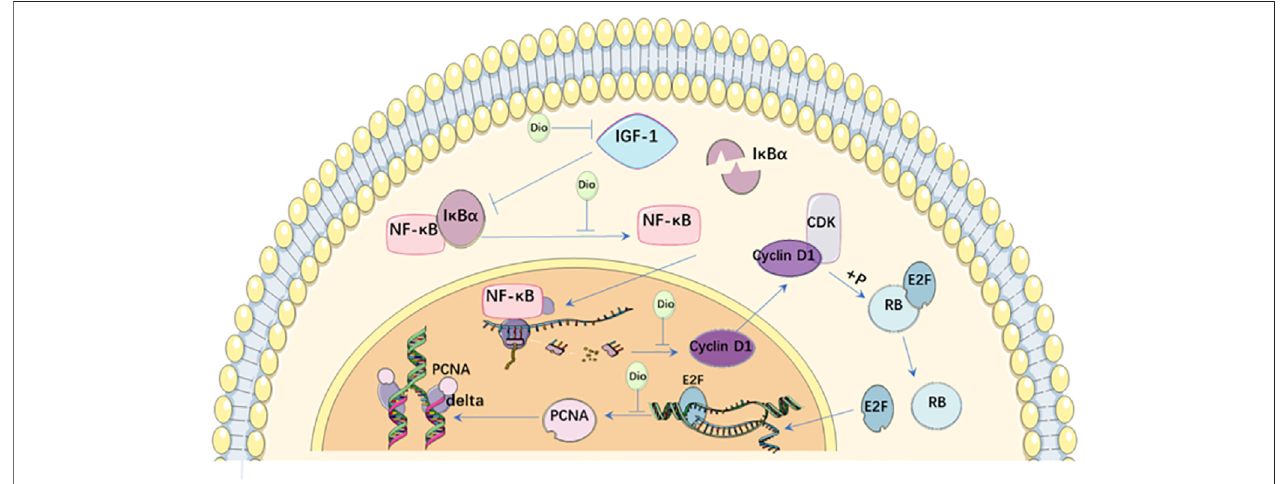
FIGURE 2 | Action mechanisms of Dio on Graves ’